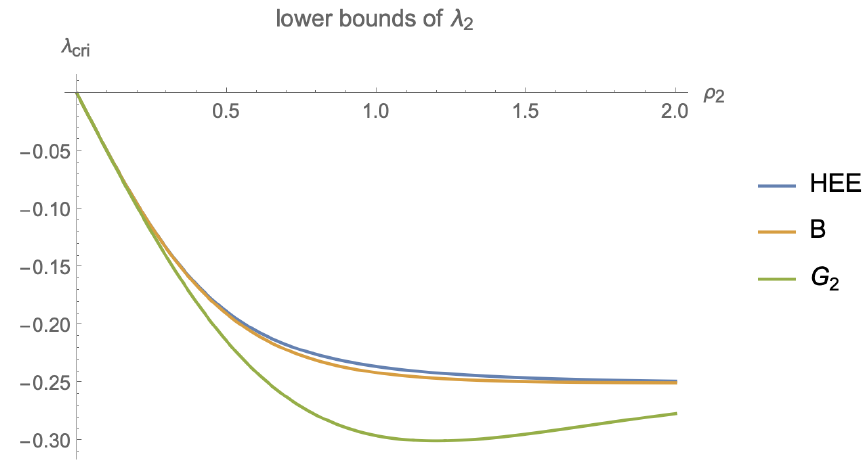
Figure 6 . Various lower bounds of the DGP parameter λ 2 for ρ 1 = 0 , λ 1 = 0 , d = 4 , i.e., λ 2 ≥ λ cri . The blue, orange, green curves denote the lower bounds derived from HEE (2.55), brane bending modes (2.48), effective Newton’s constants (2.8), respectively. It shows that the HEE impose the strongest lower bound of λ 2 . In the large tension limit ρ 2 → ∞ , all lower bounds approach to λ cri → − 1 / (2( d − 2))